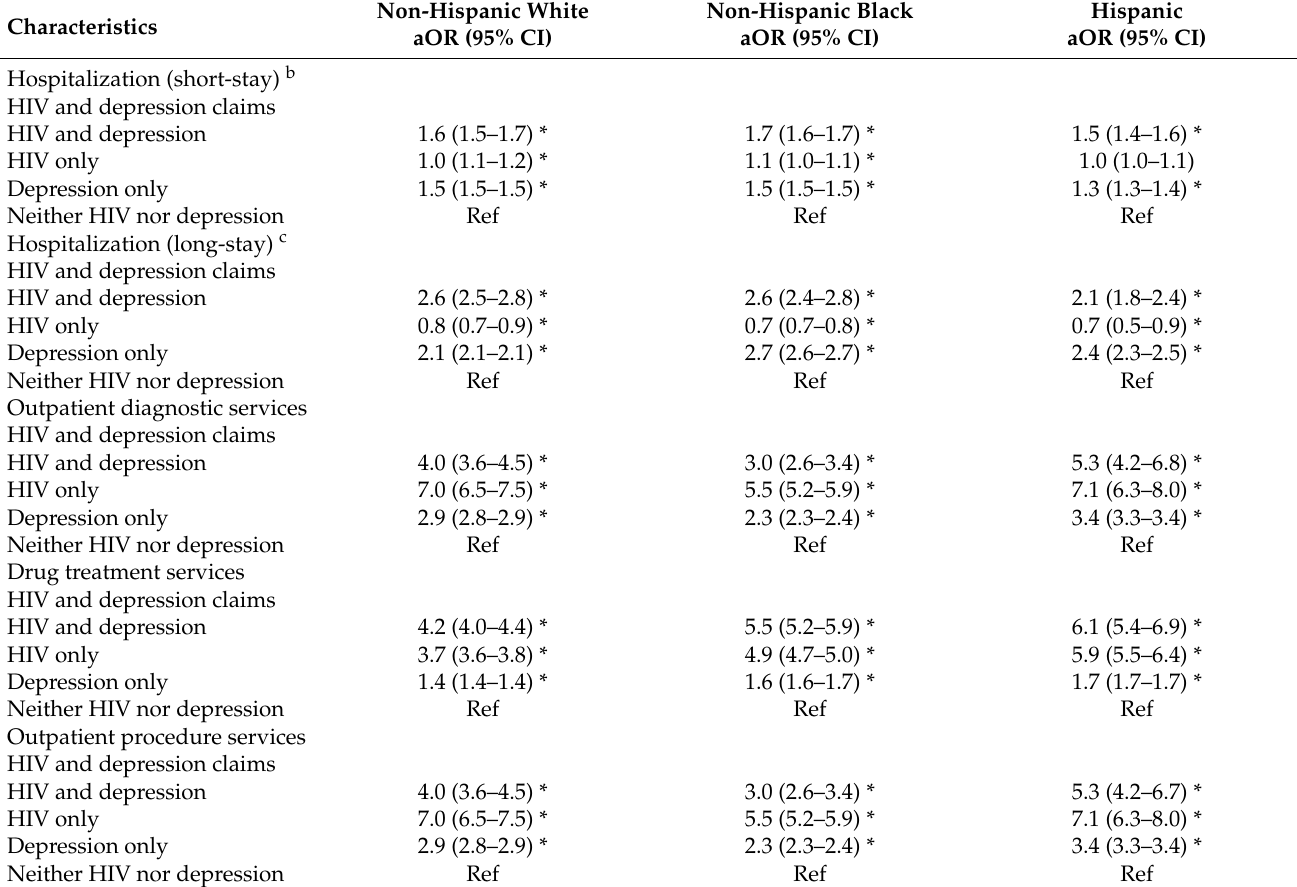
Table 4. Association of health care services utilization with HIV and depression fee-for-service claims among Medicare beneficiaries—by race/ethnicity a , United States,